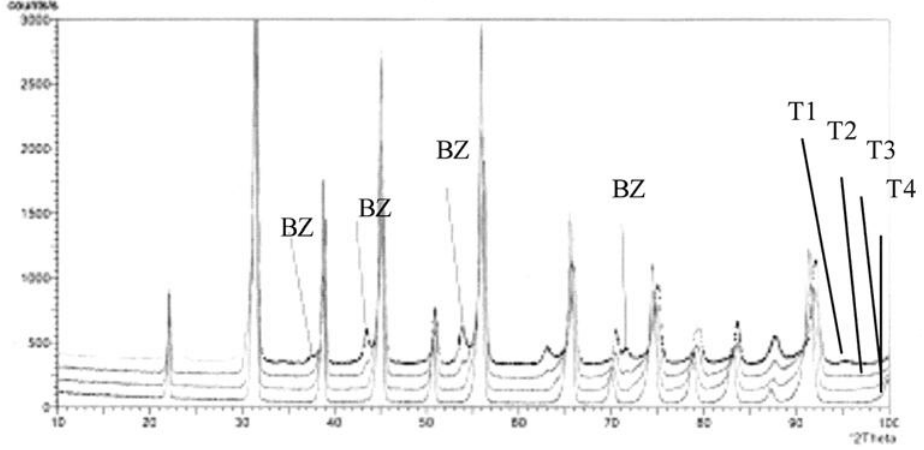
FIGURE 2 XRD of differently calcined doped BCTZ samples, T 1 < T 2 < T 3 <